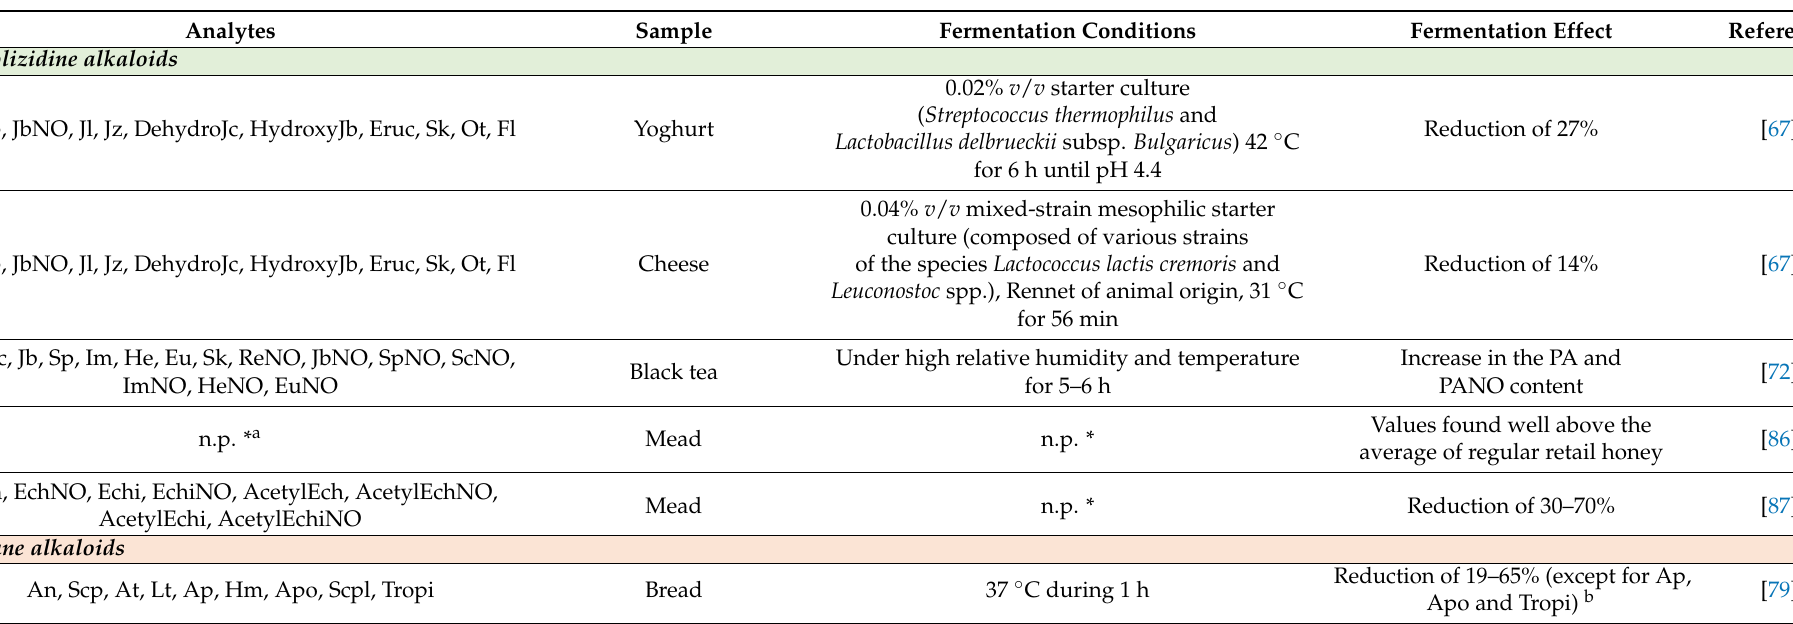
Table 2. Fermentation effects on the contents of pyrrolizidine and tropane alkaloids in food samples according to literature